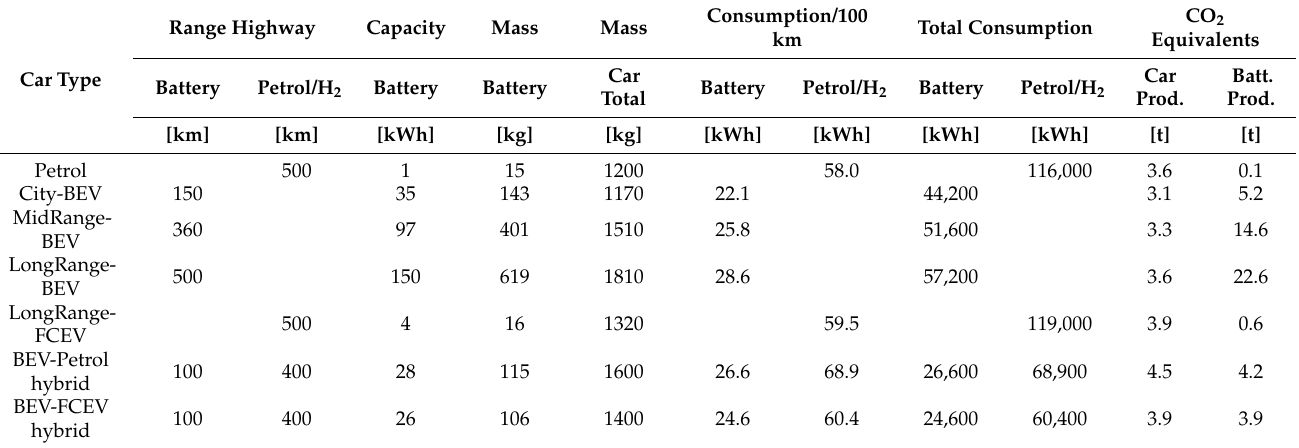
Table 1. CO 2 output for the production and use of cars of different driving systems during the lifetime of the car assuming 200,000 km mileage, 3 kg CO 2 release per kg car mass and 150 kg CO 2 release per kWh of the Li-ion battery based on the electricity production.